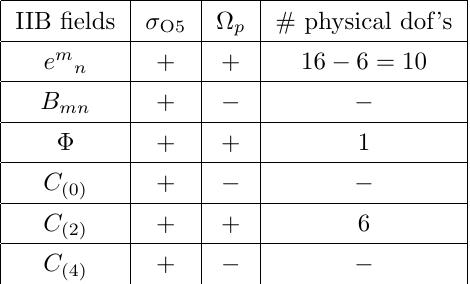
Table 15 . Counting of the total 17 propagating scalar dof’s allowed by O5-planes in type IIB compacti(cid:12)cations down to six dimensions. This is exactly the dimension of the supergravity coset given in (3.1), once we subtract from e m n the 6 unphysical directions corresponding to the compact SO(4) generators.